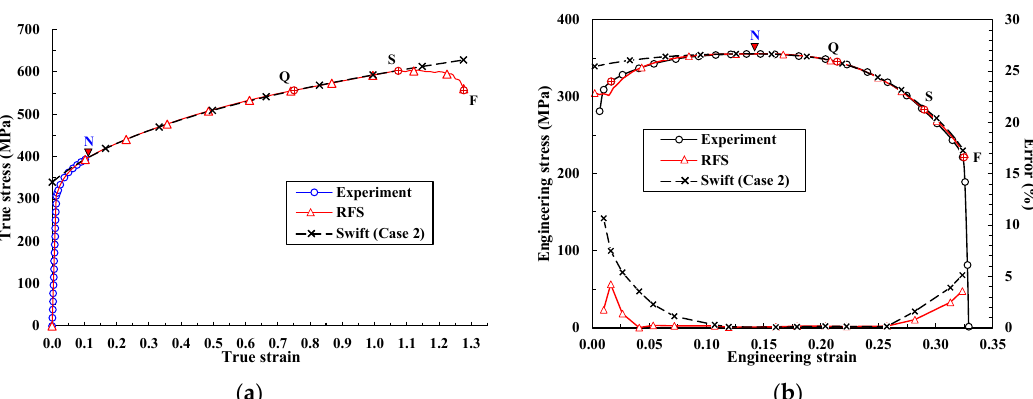
Figure 3. Flow curves of RFS and the Swift model (Case 2) and comparison of their predictions of the tensile test with the experimental tensile test. ( a ) True stress–strain curves; ( b ) engineering stress–strain curves, plotted with error percentage.